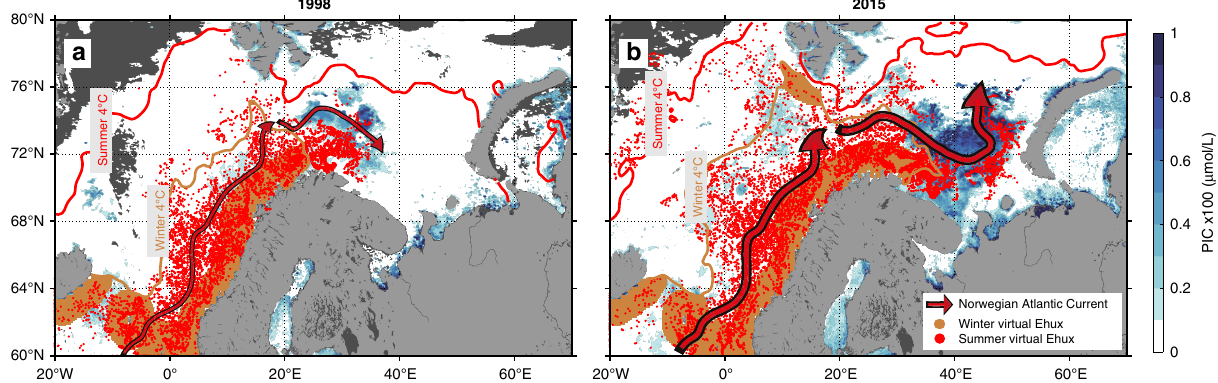
Fig. 4 Poleward expansion of Emiliania Huxleyi ( EHux ) in the European Arctic Corridor. Comparison between 1998 ( a ) and 2015 ( b ). The initialization (inoculum) of virtual particles in March are illustrated by brown dots. During 6 months, particles drift with the Norwegian Atlantic Current (red arrows) as the ocean seasonally warms as illustrated by the northward expansion of the 4 °C isotherm. In August, the particles end up in positions indicated by the red dots. In the background, remotely sensed PIC indicating coccolithophore biomass in summer (July – August – September) is shown in blue colors. Areas with no data are in dark